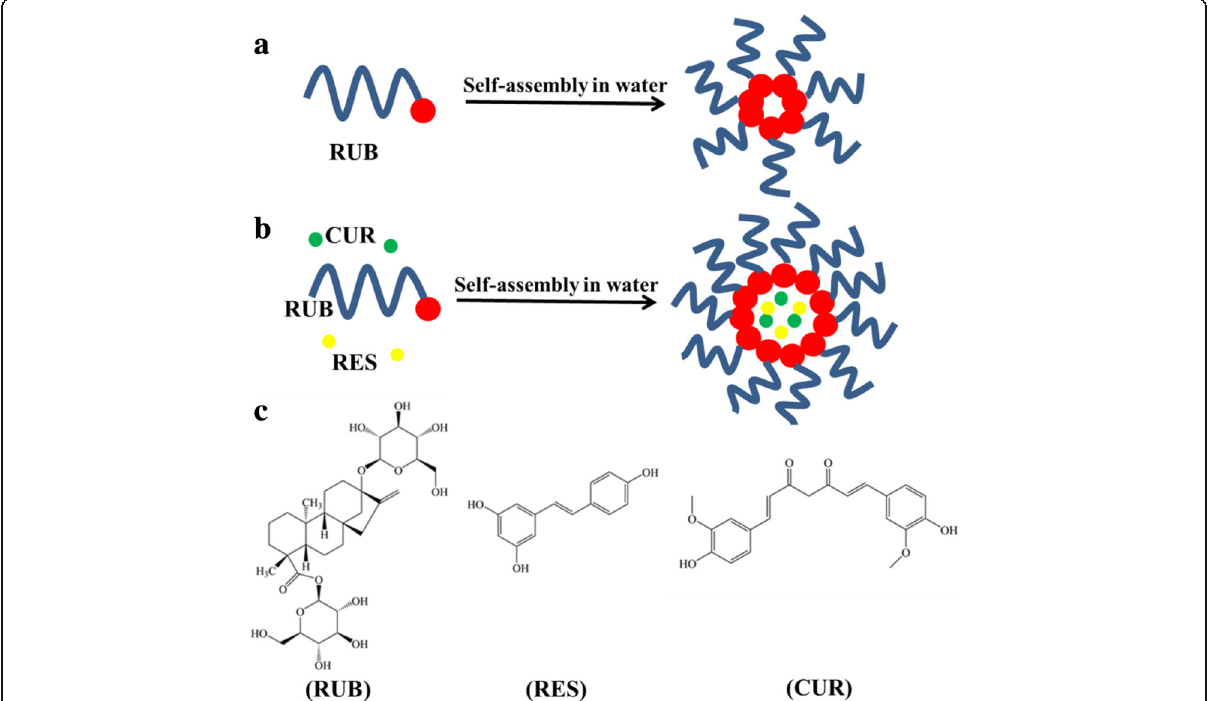
Fig. 1 Illustration of the preparation of blank RUB and drug-loaded RUB (RUB/CUR + RES) nanoparticles. a The preparation of blank RUB nanoparticles. b The preparation of RUB/CUR + RES nanoparticles. c Chemical structure of RUB, RES, and